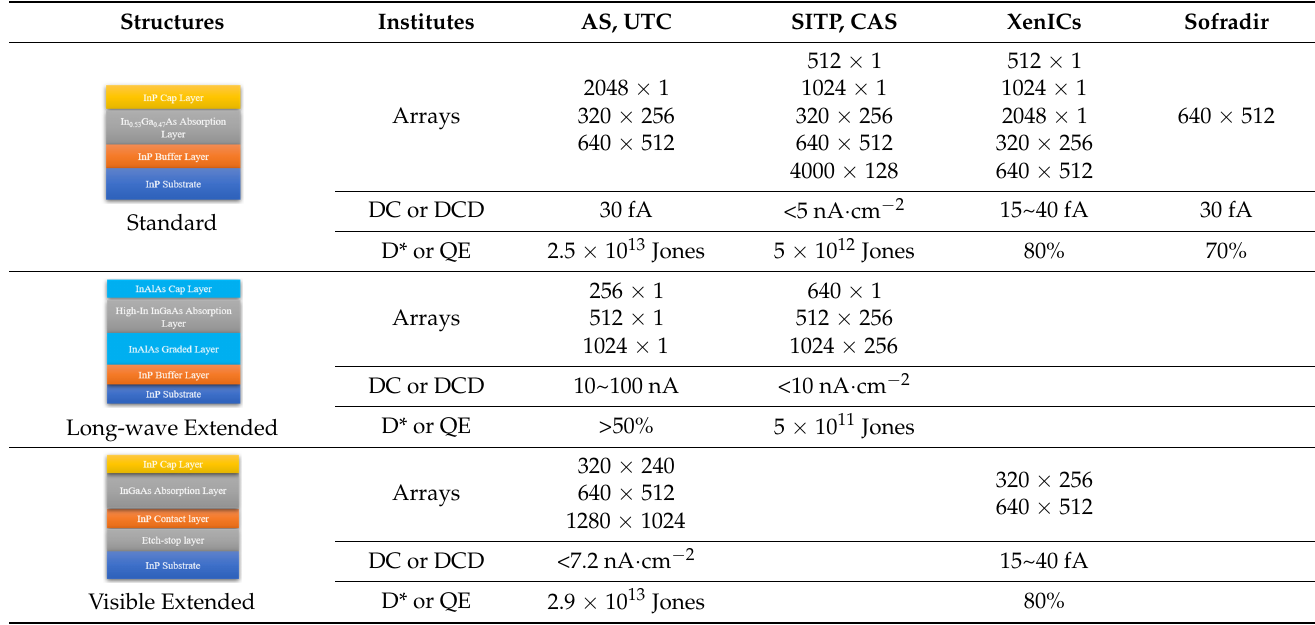
Visible Extended